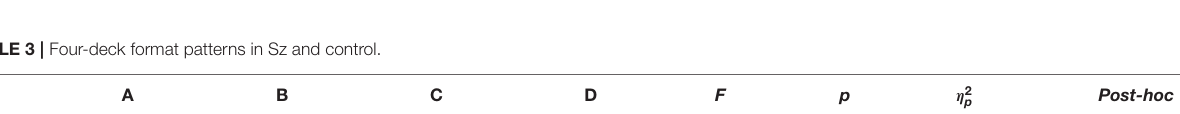
FIGURE 1 | Selective patterns of Sz and control. Green bars represent the Sz group, whereas blue bars represent the control group. Both groups selected more cards from deck B than from the other decks.